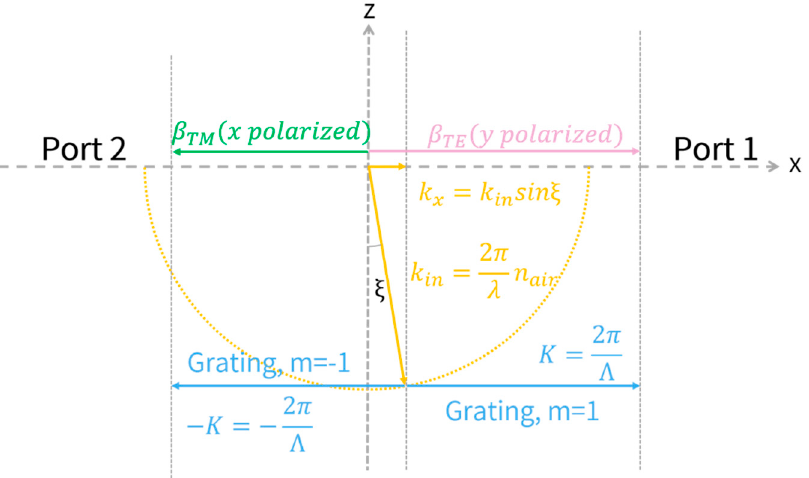
Figure 2. Graphical illustration of the Bragg condition satisfied by the polarization-splitting grating coupler.